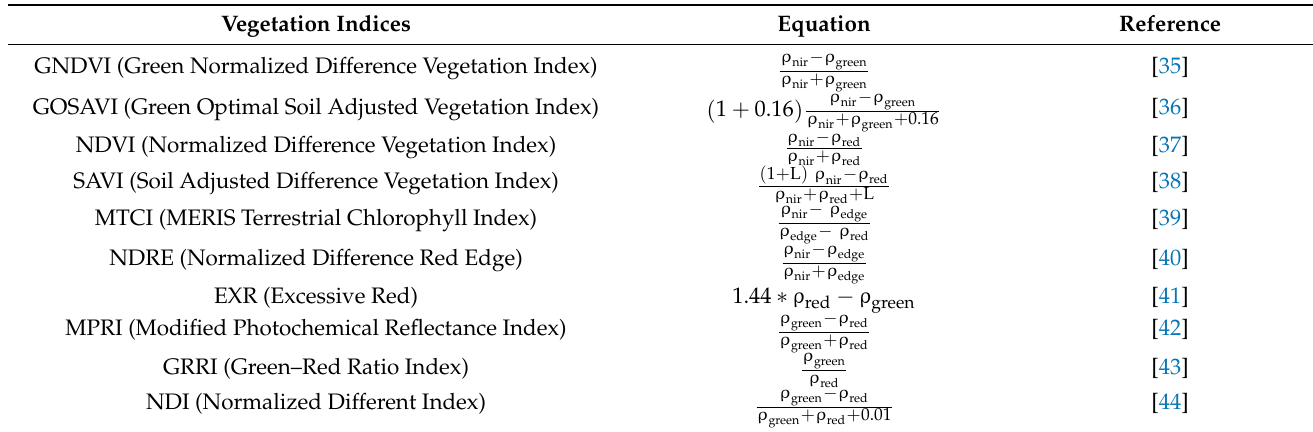
Table 2. Vegetation indices of multispectral images obtained using Remotely Piloted Aircraft (RPA). Vegetation